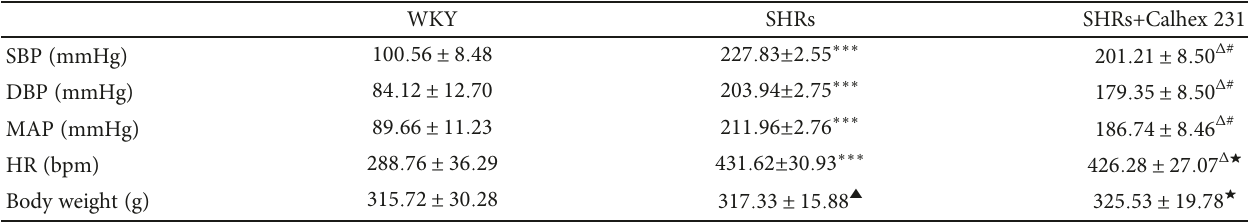
Table 1: E ff ect of Calhex 231 on blood pressure, heart rate, and body weight in